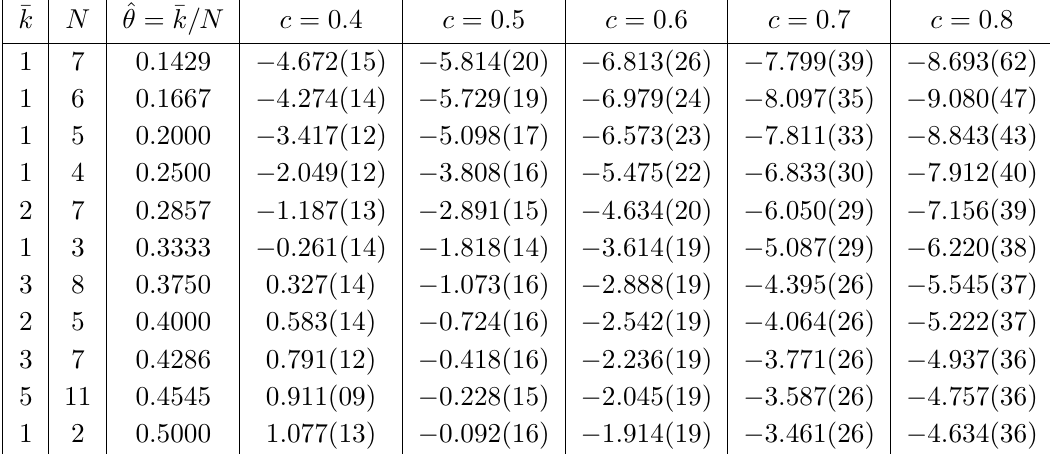
Table 2. Results for C 1 for several SU( N ) gauge groups and values of (cid:22) k .